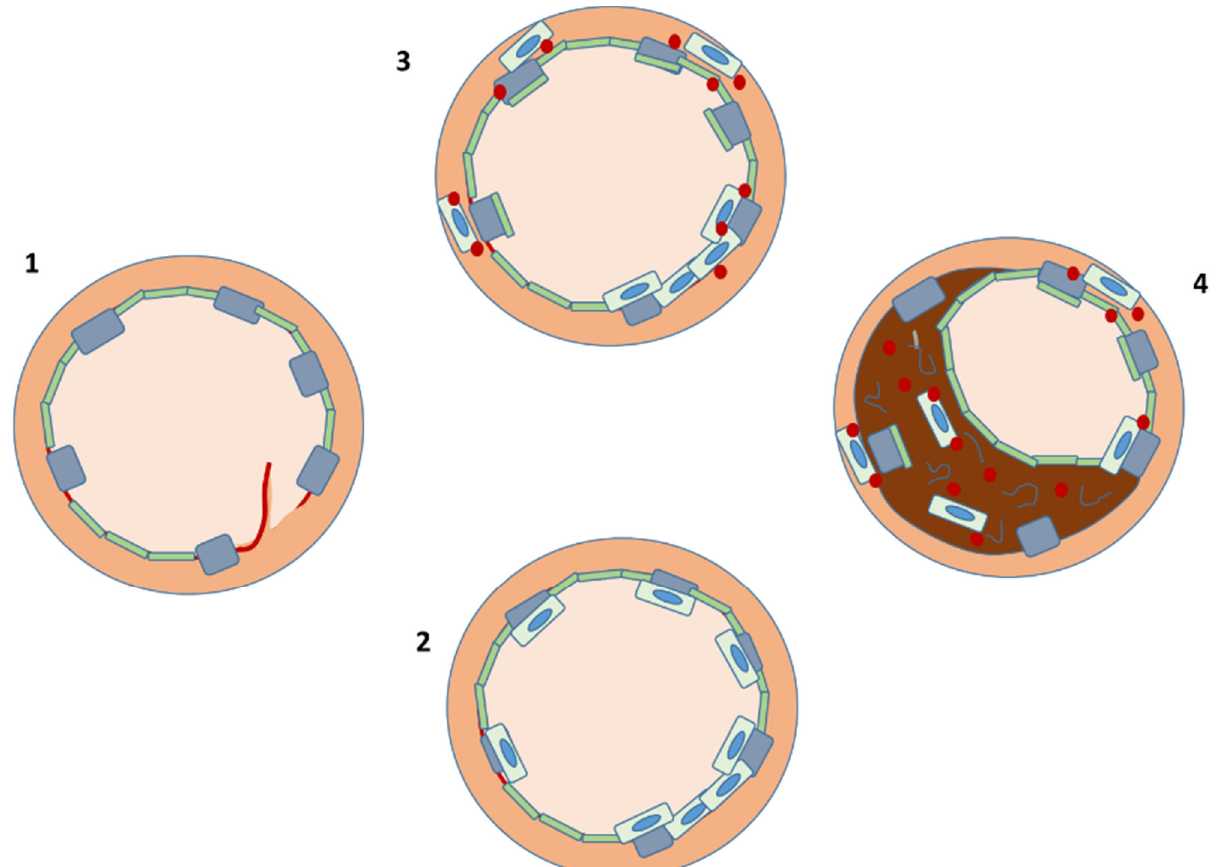
Figure 1. PCI results in arterial injury and exposure of a subendothelial proinflammatory environ- ment ( 1 ). Circulating PCs are then attracted to the site of vascular injury and support repair by ( 2 ) transdifferentiating into endothelial cells or ( 3 ) paracrine production of chemokines (red), which stimulate native endothelial cell proliferation. The same processes may, however, ( 4 ) lead to SMCs proliferation and switch to a synthetic phenotype, causing